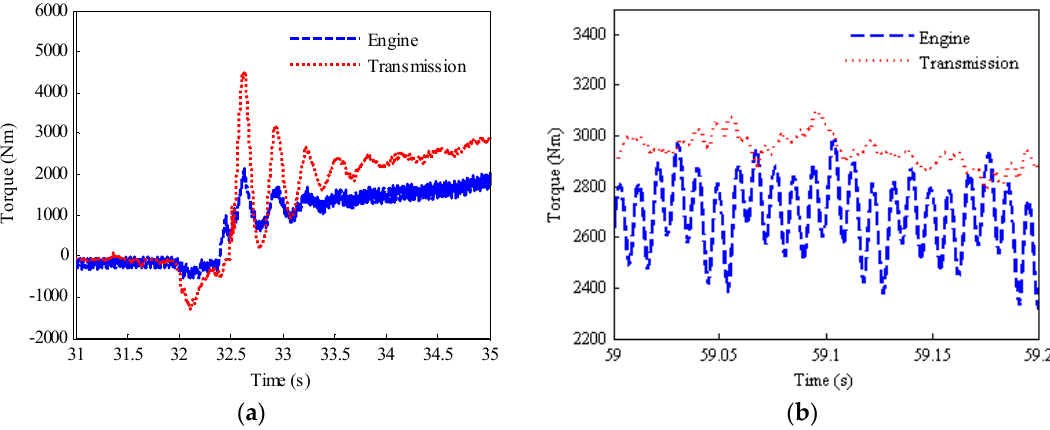
Figure 4. Time domain signals of ( a ) shifting process and ( b ) acceleration process (partial enlarged view).